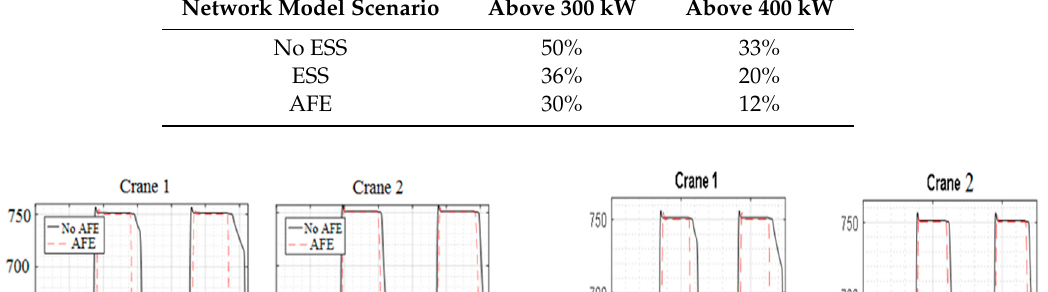
Figure 9. A histogram of the weight of containers for data collected at Port of Felixstowe over a period of four months. Table 4. Percentage of time that the secondary substation for network of two RTG cranes output is over 300 and 400 kW. Table 5. Percentage of time that the secondary substation for network of two RTG cranes output is over 300 and 400 kW.